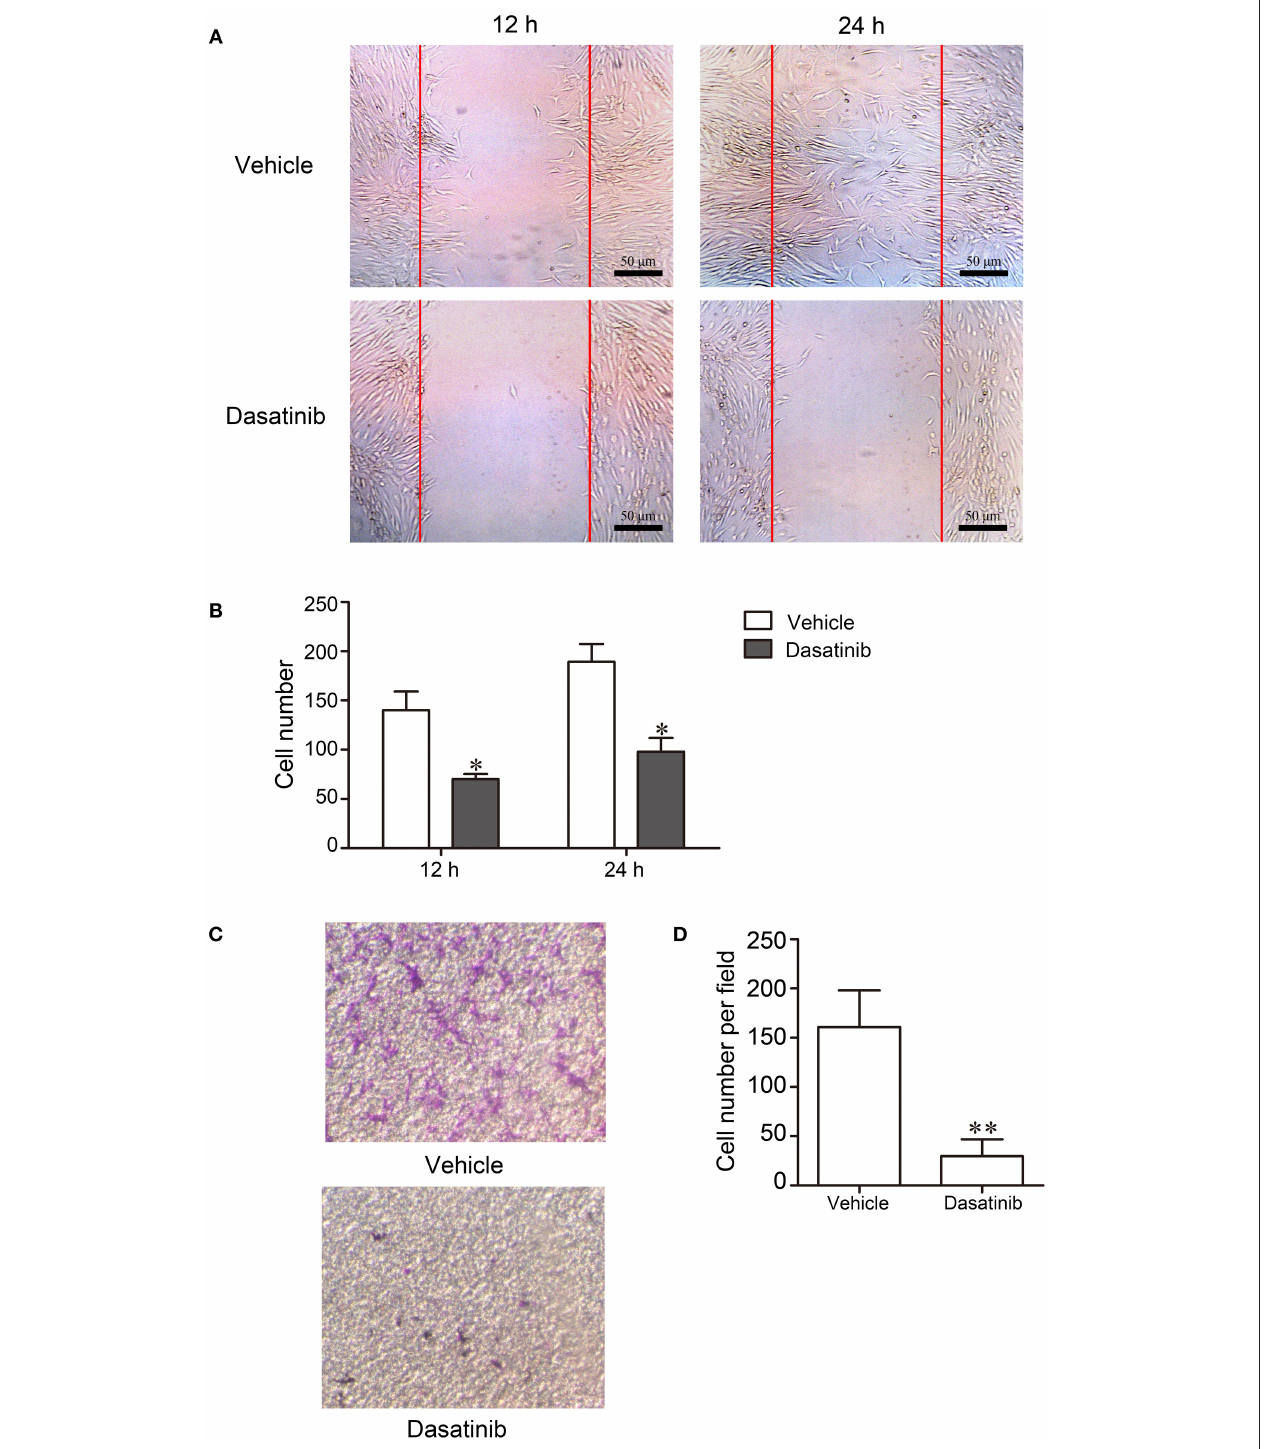
FIGURE 5 | FLS from RA patients were cultured to investigate the mechanism of dasatinib treatment of CIA. Migration of cells was evaluated using the erasion trace test and transwell migration assay. (A) Microscope observation of FLS treated with dasatinib and control vehicles in the erasion trace test. (B) The number of cells that migrated to the wound region in 12 and 24h. (C) Microscope observation of FLS that migrated through the porosity polycarbonate filters to the lower surface of the inserts. (D) The number of cells on the lower surface of the inserts in the transwell migration assay. * P < 0.05, ** P < 0.01 vs. vehicle group ( n = 3 per group).